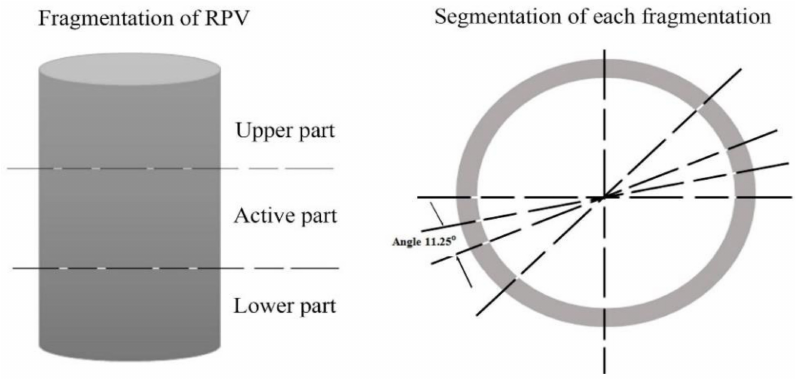
Figure 3. Description of reactor pressure vessel (RPV) and cylindrical cutting